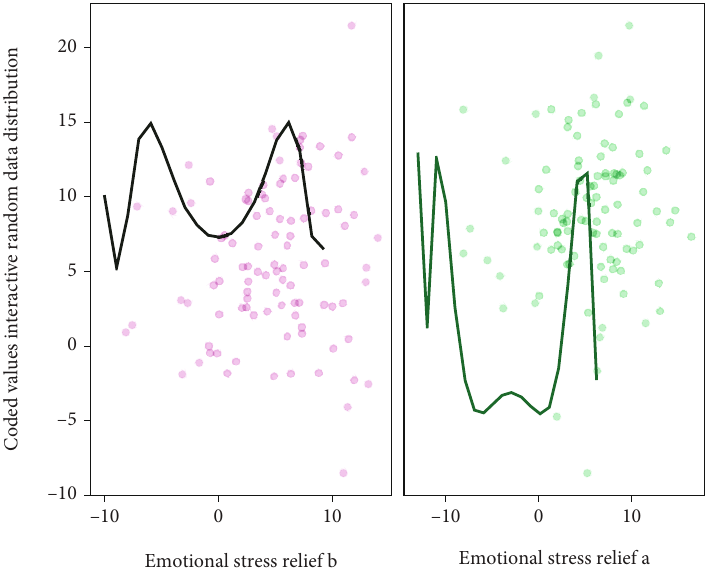
Figure 5: Random data distribution of emotional stress